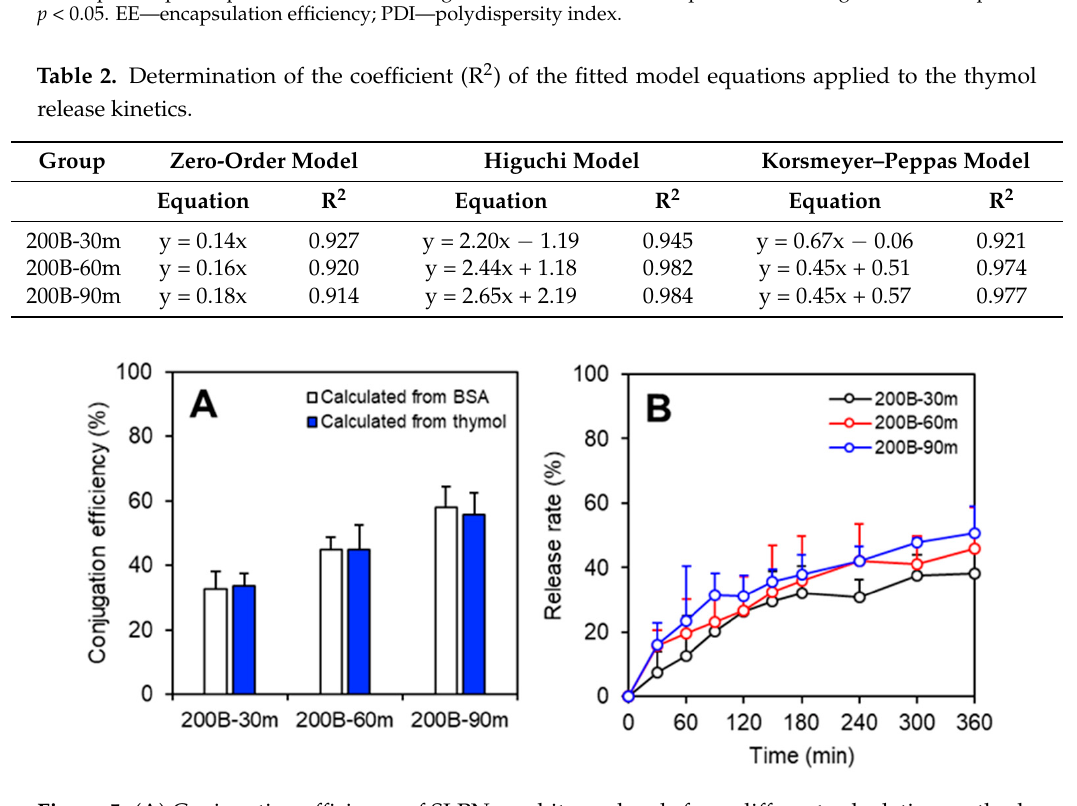
Table 1. Particulate characteristics of thymol loaded solid lipid–polymer hybrid nanoparticles (SLPN). Group The capital superscript letter indicates the significant difference in that parameter among different